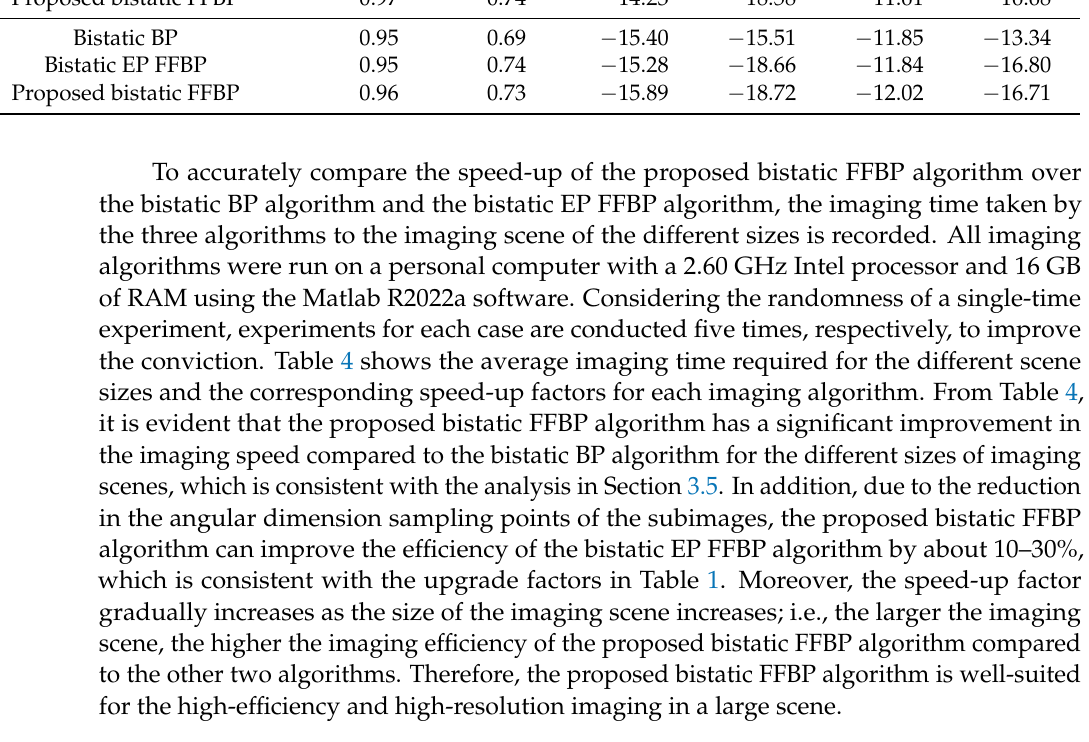
Table 4. Average imaging time of the bistatic BP algorithm, bistatic EP FFBP algorithm and proposed bistatic FFBP algorithm for the imaging scene with the different